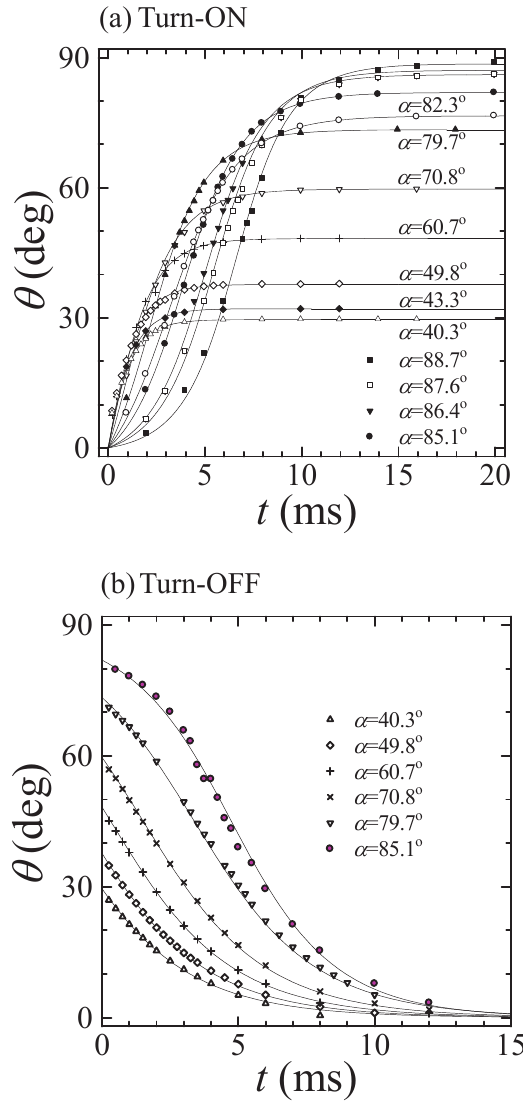
Figure 3. Plot of the angle θ ( t ) vs. time t for the turned-on ( a ) and the turned-off ( b ) processes obtained for a number of values of α [11]. The symbols were obtained from the time dependence of ∆ ν ( θ ) / ∆ ν ( ≡ P ( cos θ )) , whereas the solid lines were obtained from the torque balance equation for a 0 2 monodomain